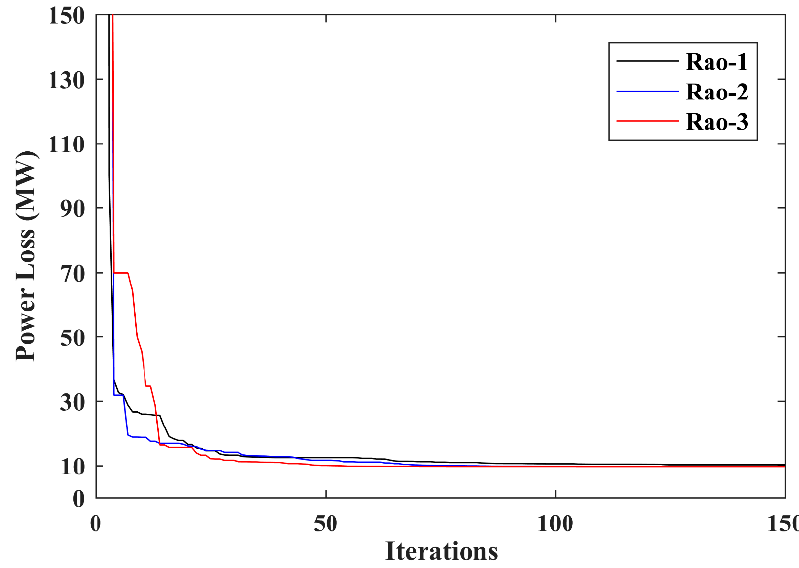
Figure 8. Convergence characteristic for the IEEE 57-bus system, Case